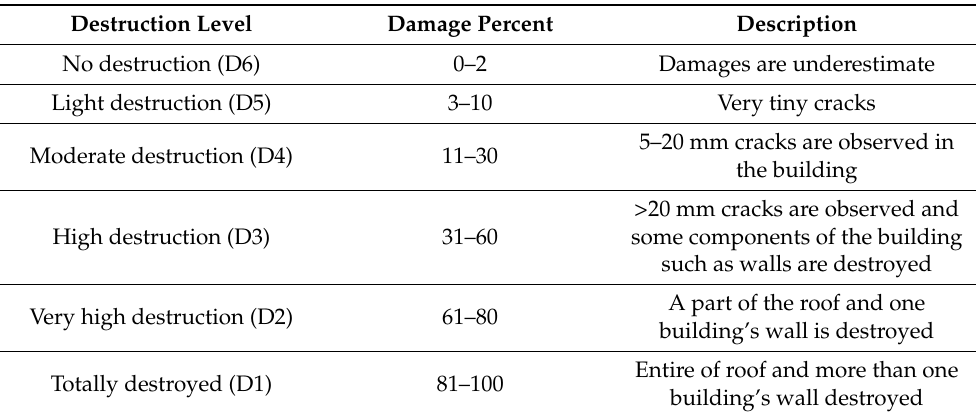
Figure 9. Fragility curves of 6 building types in the study region as a function of the Modified Mercalli Intensity scale (MMI) [88]. Table 4. Description of the building damage level estimated by Hassanzadeh et al. [35] and the corresponding damage level estimated by EMS 1998